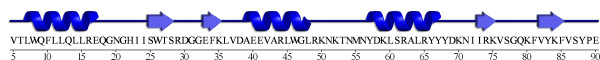
ETS domain secondary structure. Amino acid sequence of the Elk-1 ETS domain, showing the locations of α-helices and β-strands.